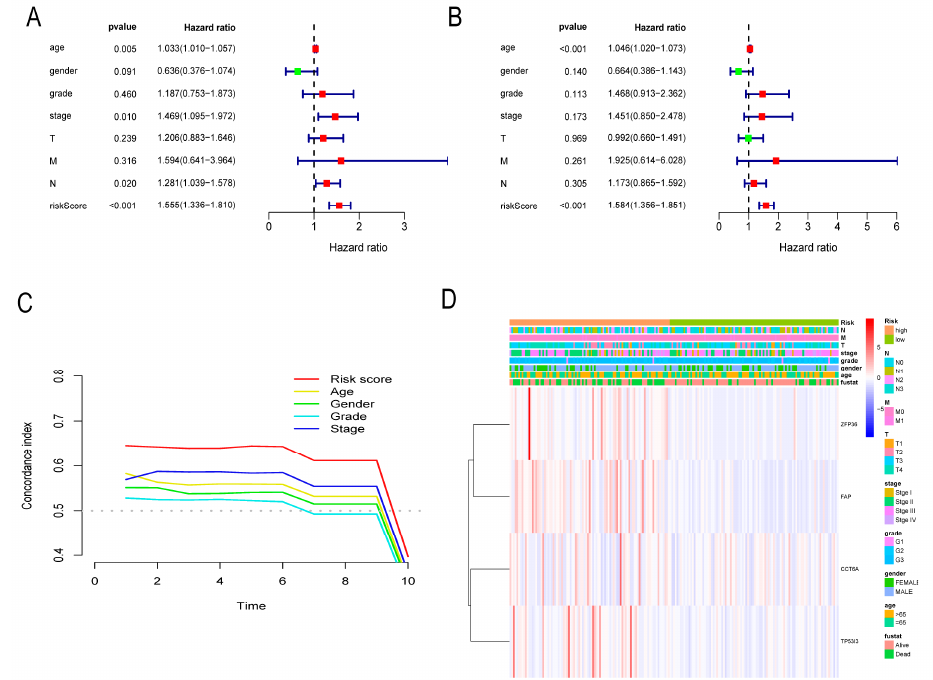
Figure 7. Independent prognosis and clinical-related identification. ( A ) Univariate risk proportional regression showed that risk score was significantly correlated with OS. ( B ) Multivariate proportional hazard regression showed that the risk score was an independent prognostic indicator of poor GC out- comes. ( C ) The c-index curve showed that the independent prognostic ability of risk score was better than that of other clinical features. ( D ) Heatmap of risk score, model gene, and clinical